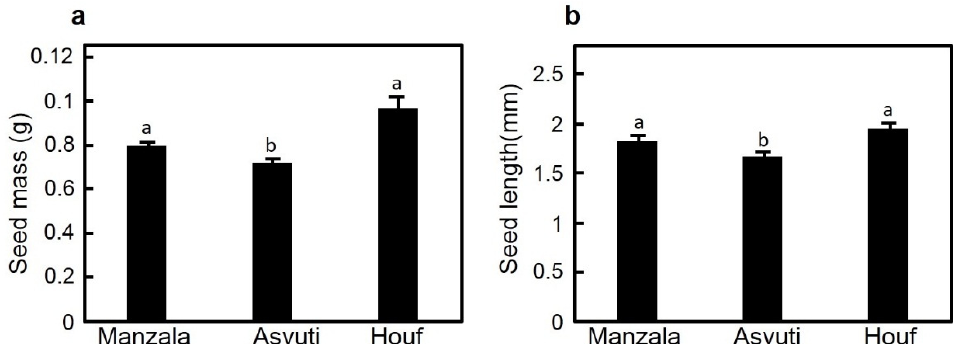
Figure 1. Comparison of ( a ) seed mass and ( b ) seed length of Zygophyllum coccineum from Manzala coast, Wadi Asyuti and Wadi Houf. Value represents the mean of 100 seeds ± standard error, p -value < 0.05. For variables denoted with the same letter, the difference is not statistically significant.